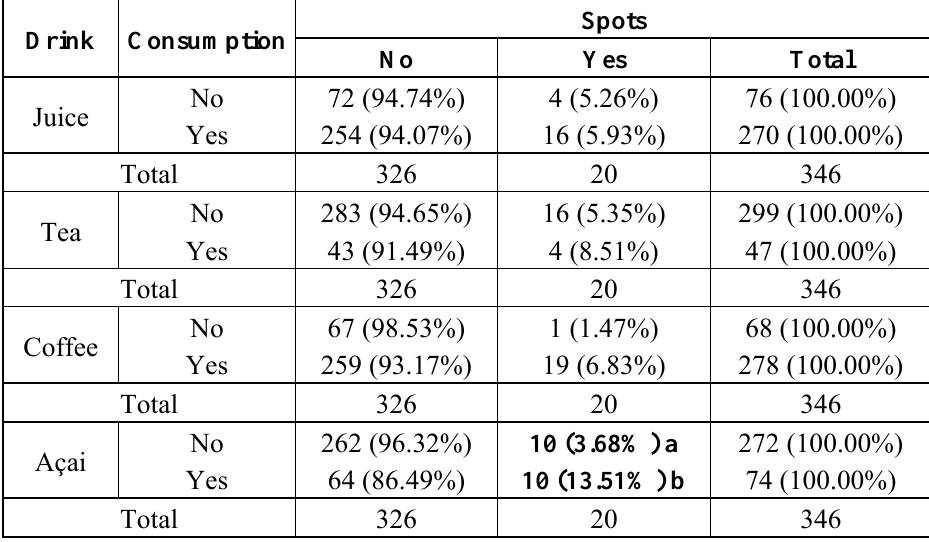
Table 6. Number and percentage of subjects according to presence or absence of extrinsic enamel stains according to the consumption or not juice, coffee, tea, and açai, Caapiranga, AM, Brazil, 2011.